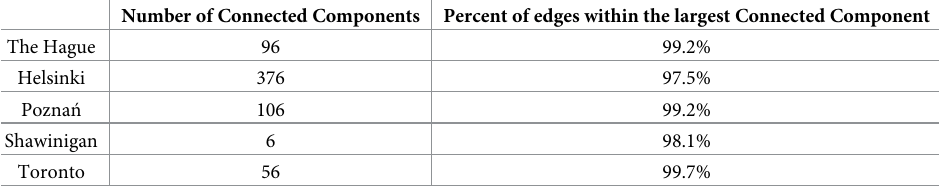
Table 2. Connected components within the OSM data per